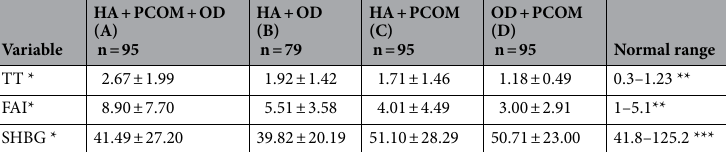
Table 1. Basic features of PCOS diagnosis in each phenotype group. PCOS Polycystic Ovary Syndrome, PCOM : Polycystic Ovaries Morphology, OD Ovulatory Dysfunction, HA Hyperandrogenism, TT Total Testosterone, SHBG Sex Hormone Binding Globulin, FAI Free Androgen Index. *Data are given as Mean ± SD. ** ng/dL, *** nmol/L.